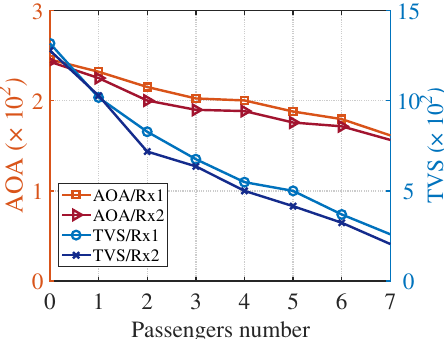
Figure 6. AOA and TVS value under different passenger